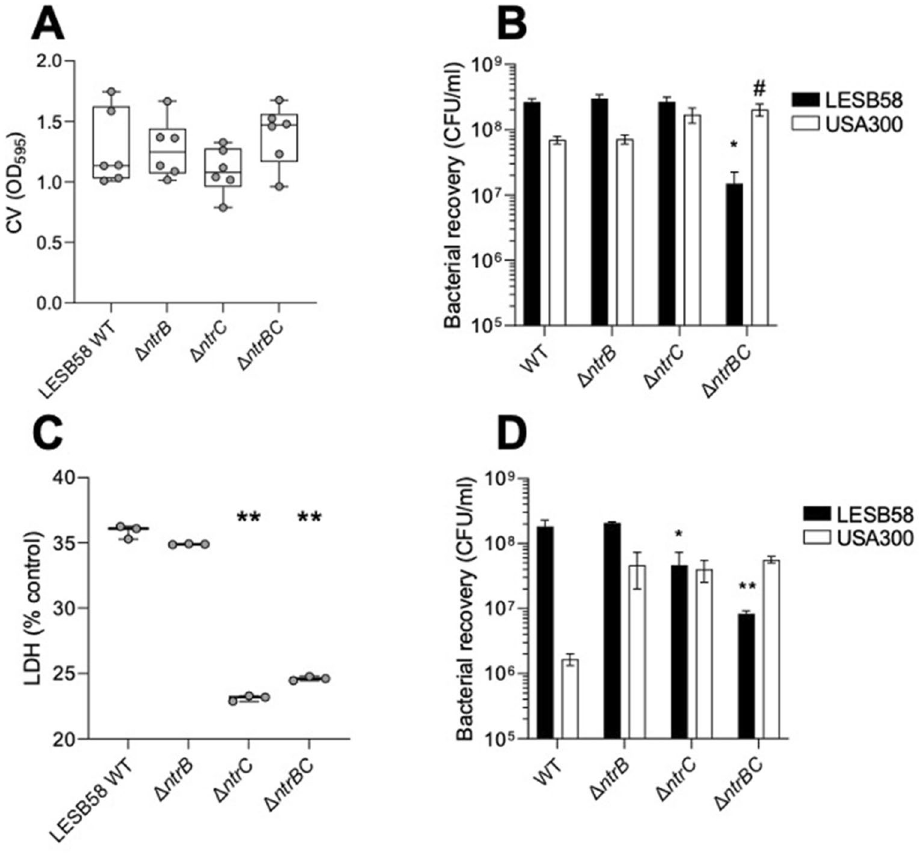
Figure 4. NtrBC-dependent competitive advantage of P. aeruginosa LESB58 over S. aureus USA300 LAC was observed in human organoids. Biofilms were formed with P. aeruginosa LESB58 strains ( A,B ) in DMEM with FBS and glucose on polypropylene plates or ( C,D ) on human skin organoids. In vitro biofilms were (A) stained with CV and ( B ) scraped for bacterial enumeration on selective media. Skin organoids ( C ) were assessed for LDH release from skin cells and ( D ) biofilm bacteria were enumerated after 18–24 h. Data are presented as mean ± standard error of the mean (SEM) and box plots delineate interquartile range for data from three independent experiments with one or two biological replicates in each ( n = 3–6). * P < 0.05, ** P < 0.01 different than biofilms formed with LESB58 WT according to one-way ( C ) or two-way ( B , D ) ANOVA followed by Dunnett’s post-hoc analysis. # P < 0.05 different than biofilms formed by USA300 LAC with LESB58 WT according to two-way ANOVA ( B ) followed by Dunnett’s post-hoc